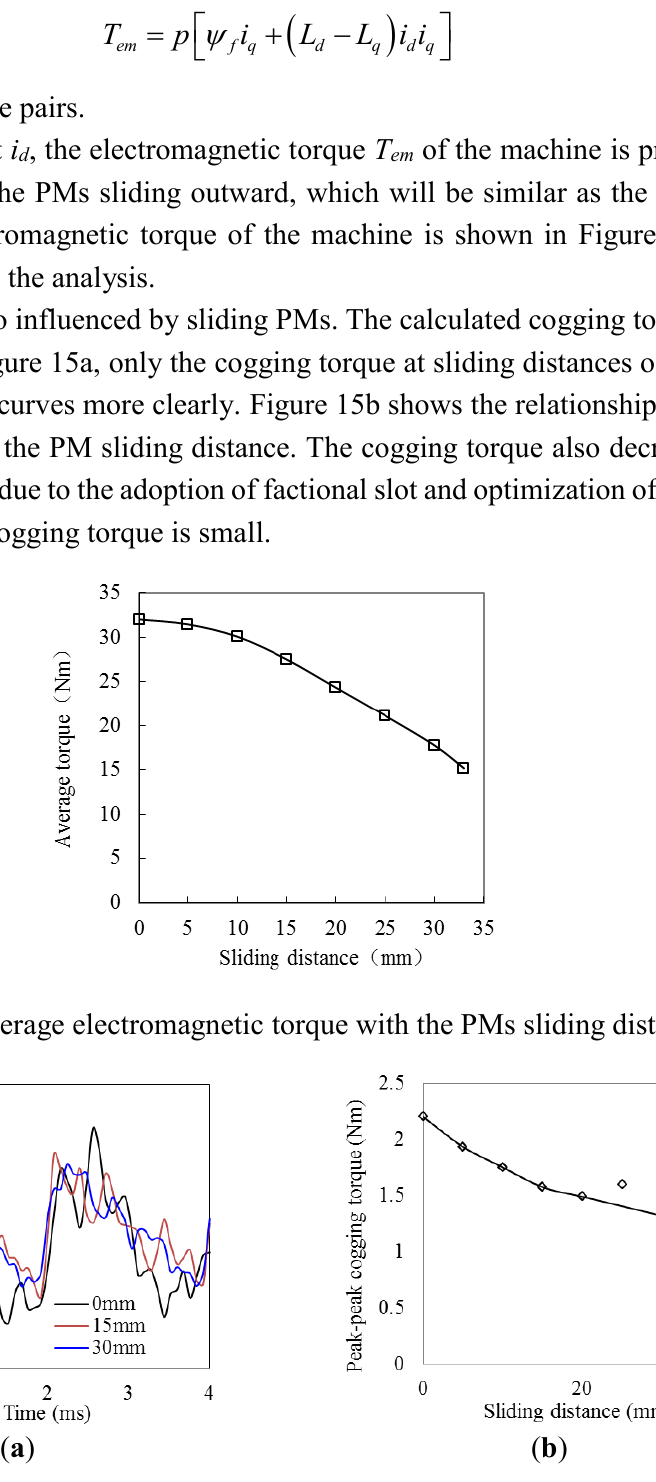
Figure 15. Cogging torque with the PMs sliding distance: ( a ) cogging torque curve, ( b ) peak-peak value of cogging